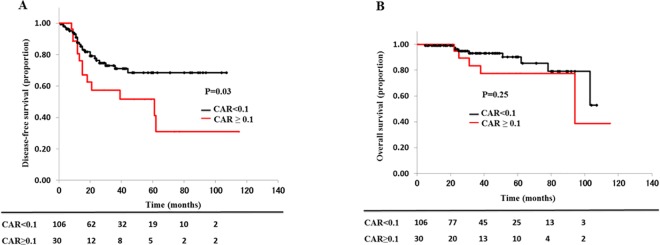
Kaplan-Meier curves of the effect of the CAR on DFS and OS.Disease-free survival is better in the L-group than in the H-group (p = 0.03). However, there is no significant difference in overall survival between the two groups (p = 0.25) (Fig 1B). CAR, CRP to albumin ratio; OS, overall survival; DFS, disease-free survival.